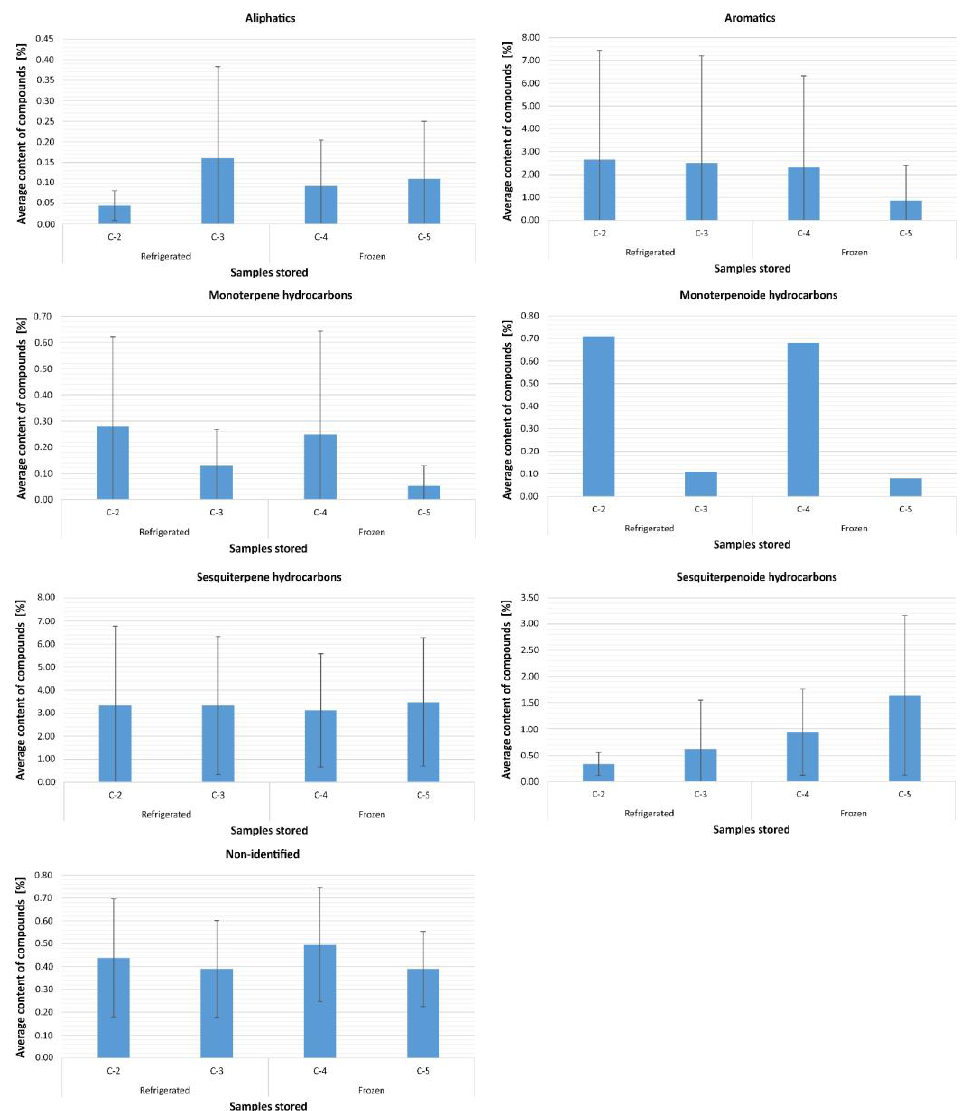
Figure 5. Average content of volatile compounds depending on the storage